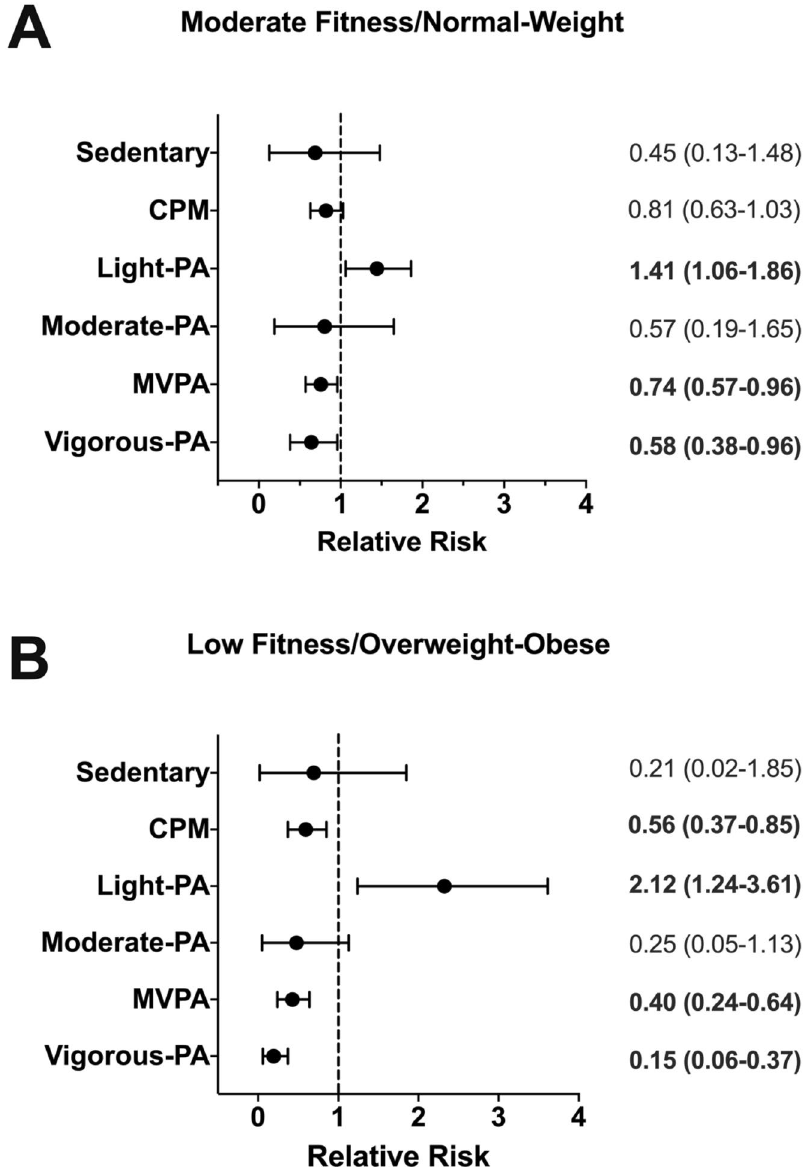
Figure 3. Relative risk ratios of being in the moderate fitness/ normal weight or in the low fitness/overweight- obese trajectory according to physical activity intensities. Data are presented as relative risk ratios (RRR) and (95% confidence intervals). RRR for sedentary behaviour is reported for every 25% time spent; light and moderate PA is reported for every 5% time spent, while vigorous PA and MVPA are reported for every 2% time spent at that intensity, CPM is reported per standard deviation (SD:137.7496); Reference group is children assigned to the ‘high fitness/normal weight’